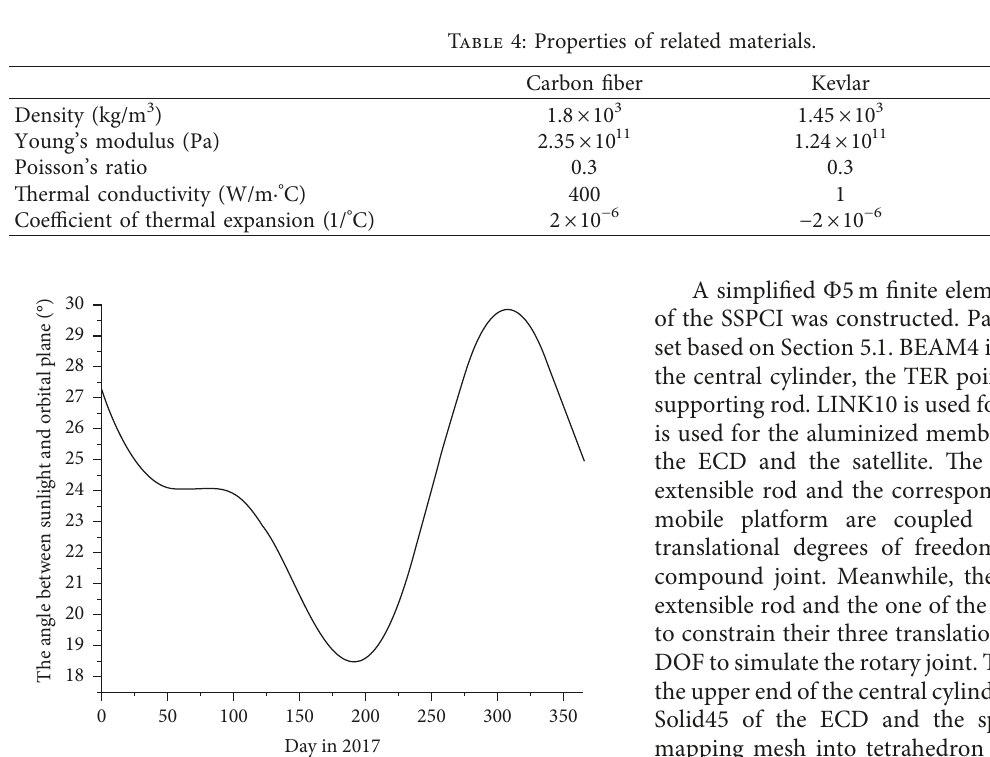
Figure 12: Angle between the sun vector and orbital plane.